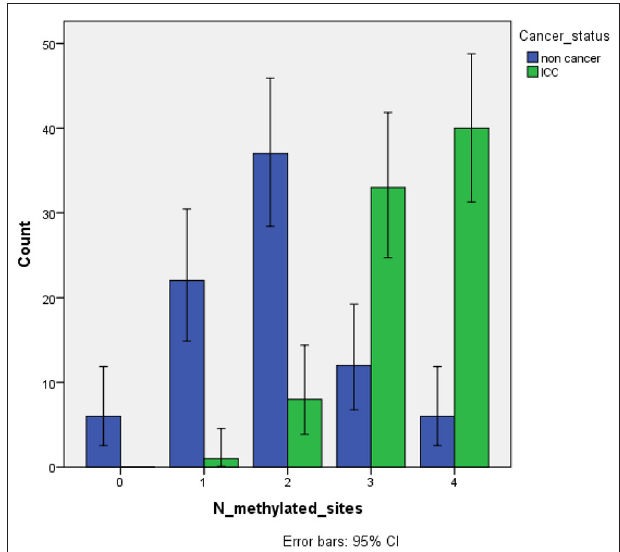
FIGURE 1 | Cervical cancer status according to the number of methylated promoters. ICC, invasive cervical cancer. In x- axis a score of 0 indicates “no methylation,” a score of 1 indicates “1 methylated site,” a score of 2 indicates “2 methylated sites,” a score of 3 indicates “3 methylated sites,” and a score of 4 “4 methylated sites”. Non cancer ( n = 83); invasive cervical cancer ( n =